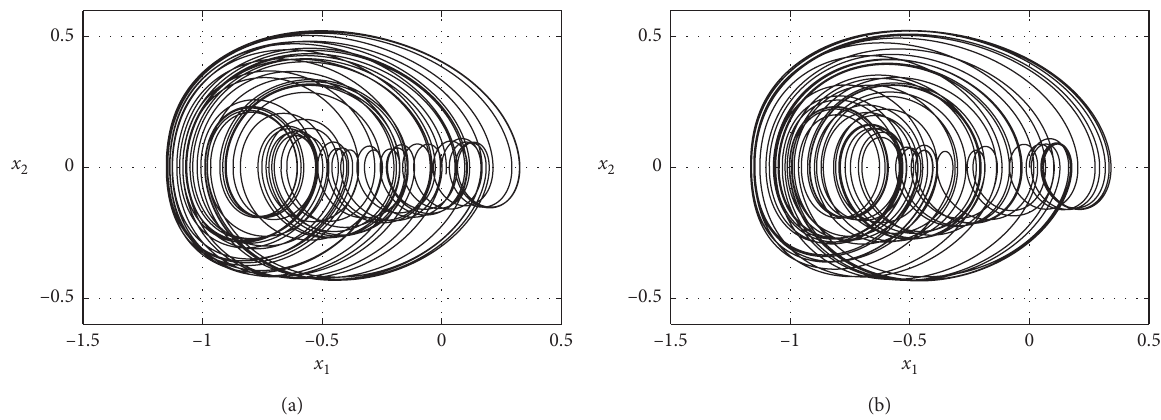
Figure 14: Phase planes of the system in fractional-order derivative equations: (a) q